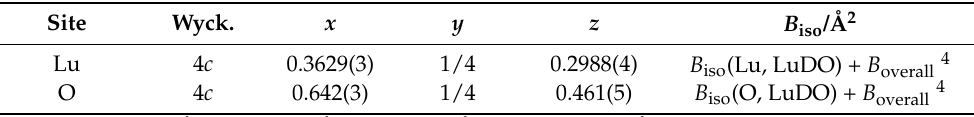
Table 4. The crystal structure parameters of orthorhombic LuHO based on X-ray diffraction data at ambient temperature 3 .